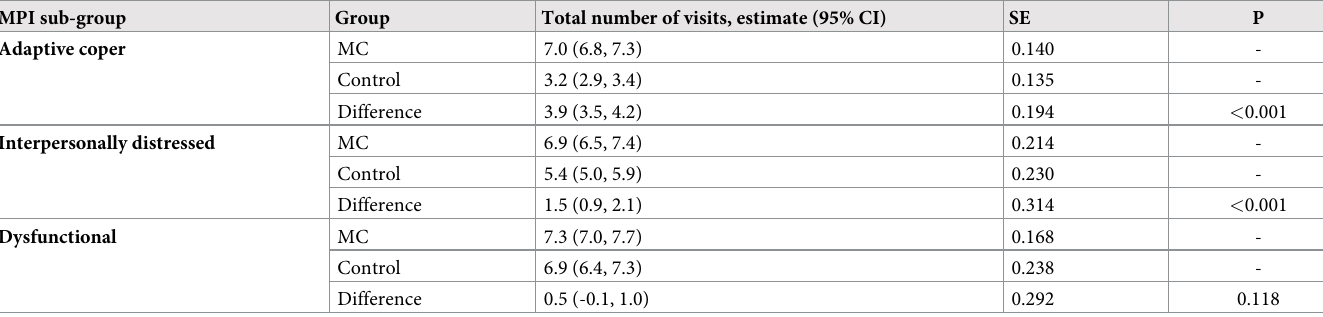
Table 3. Total number of visits during study period, group estimates and group differences